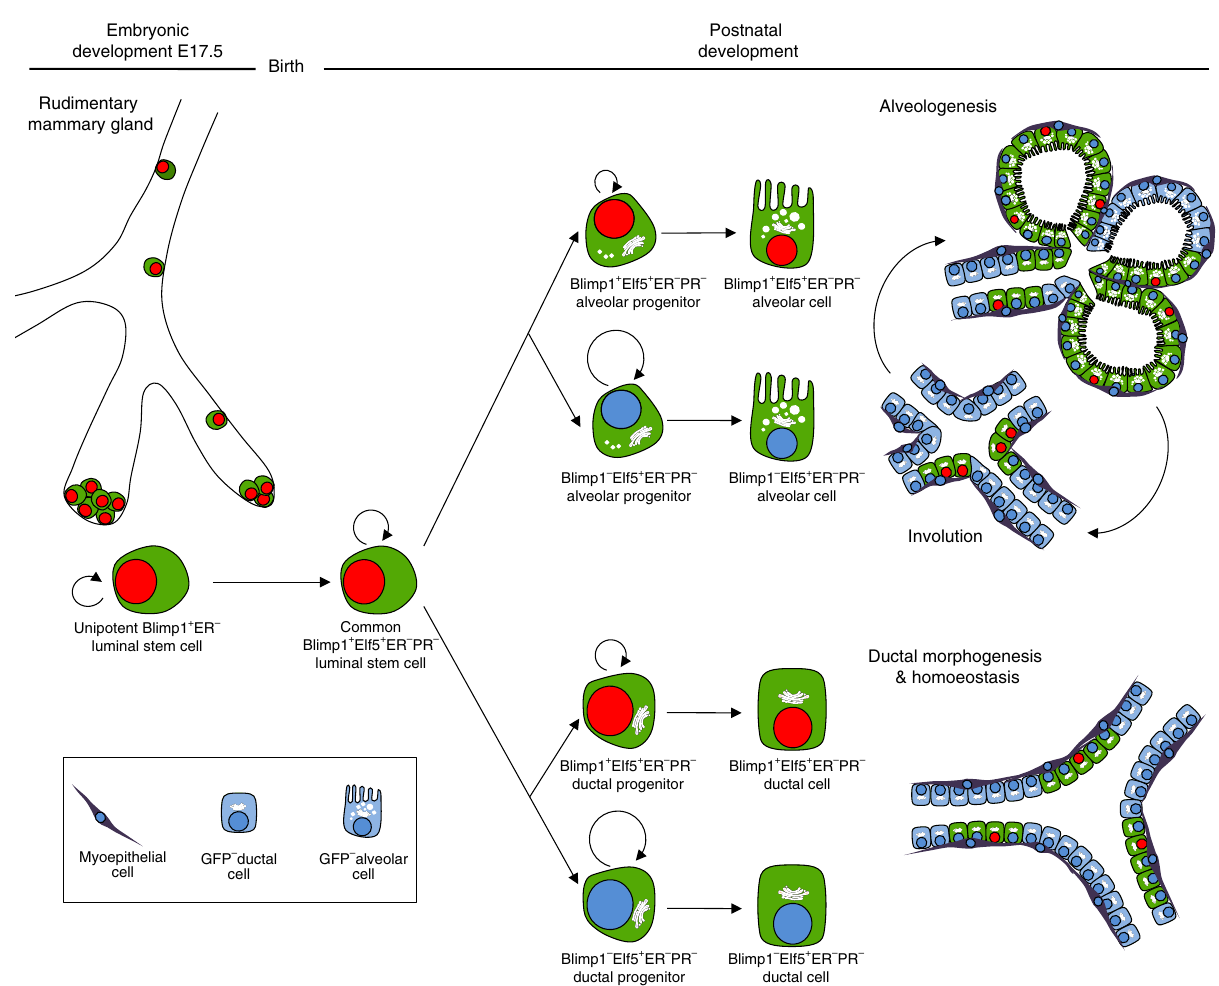
Fig. 5 Proposed model of Blimp1 mammary cell hierarchy. Lineage tracing during embryonic development uncovers a subset of Blimp1 + unipotent luminal stem cells, which specify around E17.5 where they are committed to the ER α − lineage. These unipotent stem cells contribute exclusively to the luminal compartment postnatally. After birth, a common pool of rare Blimp1 + Elf5 + ER α − PR − luminal stem cells give rise to both Blimp1 + Elf5 + ER α − PR − and Blimp1 − Elf5 + ER α − PR − ductal progenitors, which retain their identity throughout adulthood and contribute extensively to ductal morphogenesis and homoeostasis. In response to pregnancy-induced signals both Blimp1 + Elf5 + ER α − PR − and Blimp1 − Elf5 + ER α − PR − alveolar progenitors, emerging from the common Blimp1 + Elf5 + ER α − PR − luminal stem cell population, are mobilised and clonally expand to contribute extensively to alveologenesis. Blimp1 + cells survive multiple rounds of involution and give rise to Blimp1 + and Blimp1 − ductal and alveolar progenitors during subsequent tissue re-modelling, indicating that these cells behave as long-lived stem